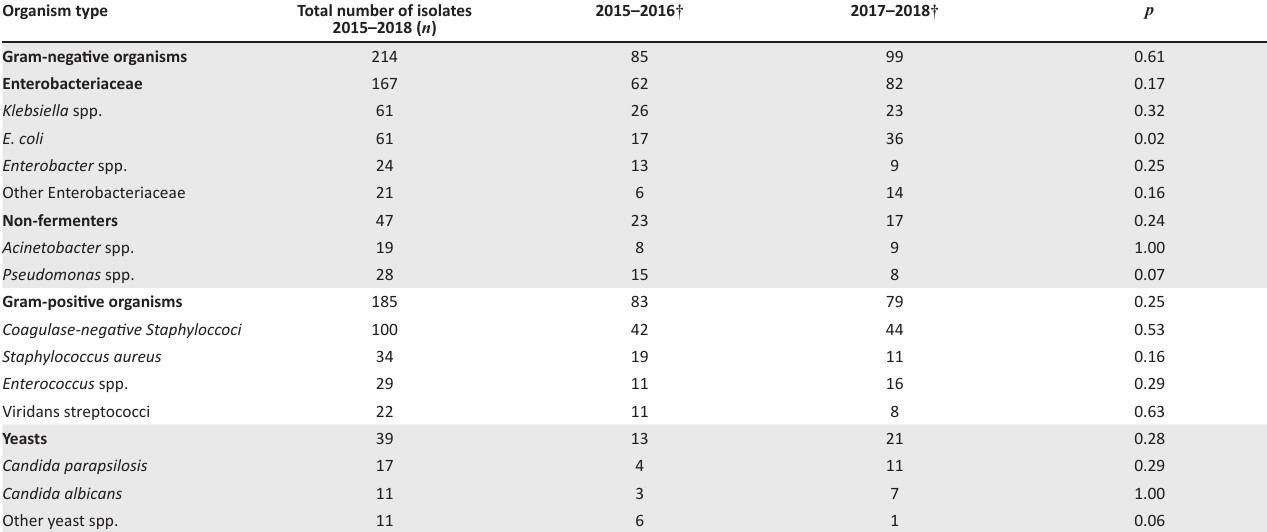
TABLE 2: Bacterial and fungal identification and frequency. Organism